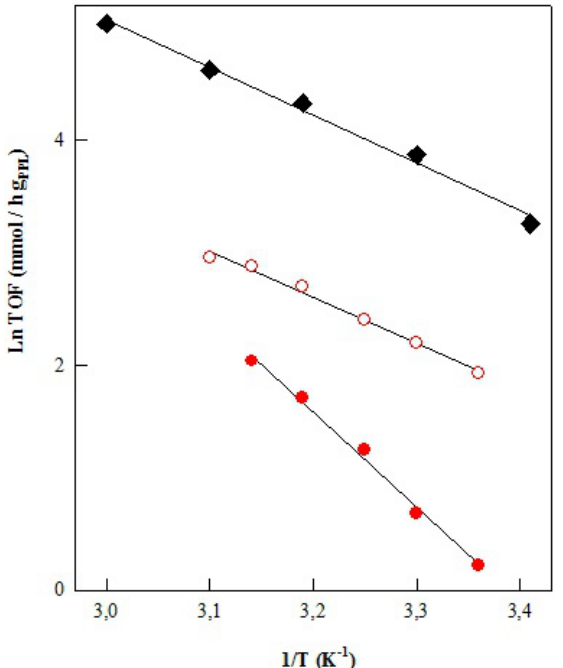
Figure 2. Arrhenius representation of enzymatic activity obtained with free and immobilized PPL, in the transesterification of sunflower oil with absolute ethanol at pH = 12: ( ♦ ) Free PPL, EtOH; ( ● ) Immob. PPL, Sunflower oil/EtOH 96% (12/6); ( ○ ) Immob. PPL, Sunflower oil/96% EtOH